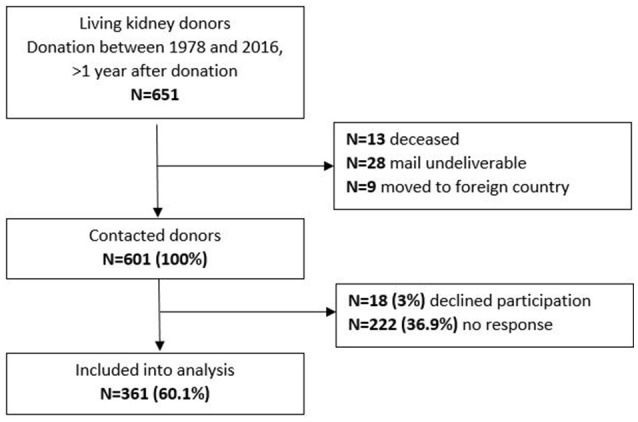
Study flow chart.